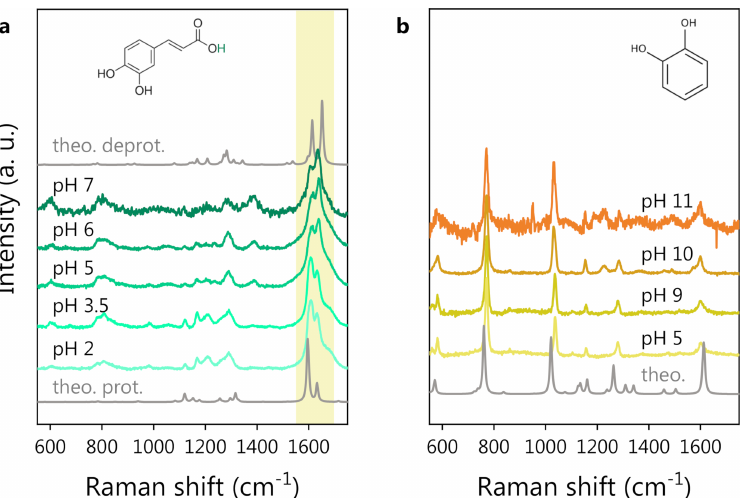
Figure 1. pH-dependent Raman study of polyphenols in water solution: ( a ) CA Raman spectra at different pH. The DFT spectra of protonated (bottom) and deprotonated CA (top, in the absence of the hydrogen atom colored green in the molecular structure) are also reported for reference in gray. The shadowed area highlights the major pH-induced spectral modifications. ( b ) CT Raman spectra at different pH. The CT molecular structure is shown at the top. The DFT spectrum of CT is also reported, in gray, at the bottom. Spectra are vertically shifted for